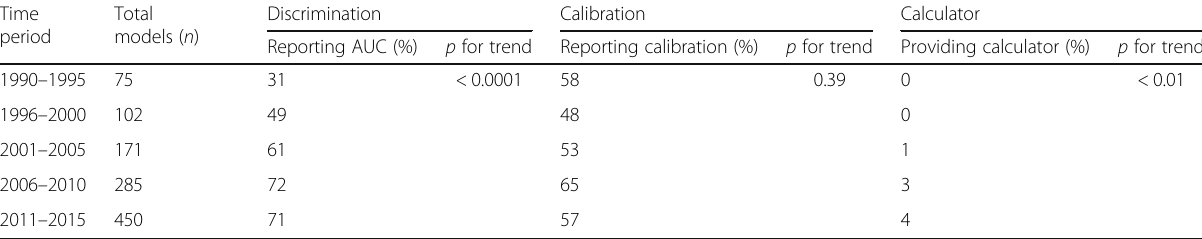
Table 3 Time trends for reporting discrimination and calibration and providing a